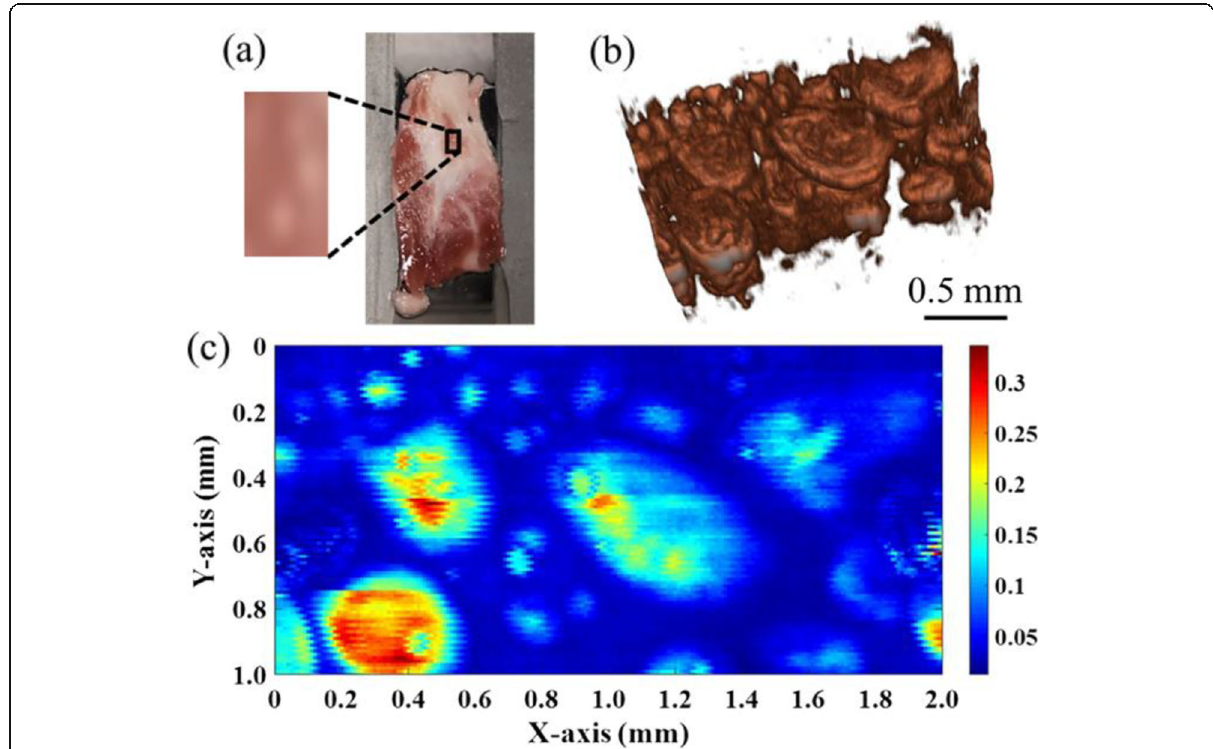
Fig. 3 Lipid PAM result with a gain-switched thulium-doped fiber laser at approximately 1720 nm. ( a ): Photograph of a fat beef slice to be imaged; ( b ): 3D imaging; and ( c ): MAP imaging results when scanning the box section in ( a )